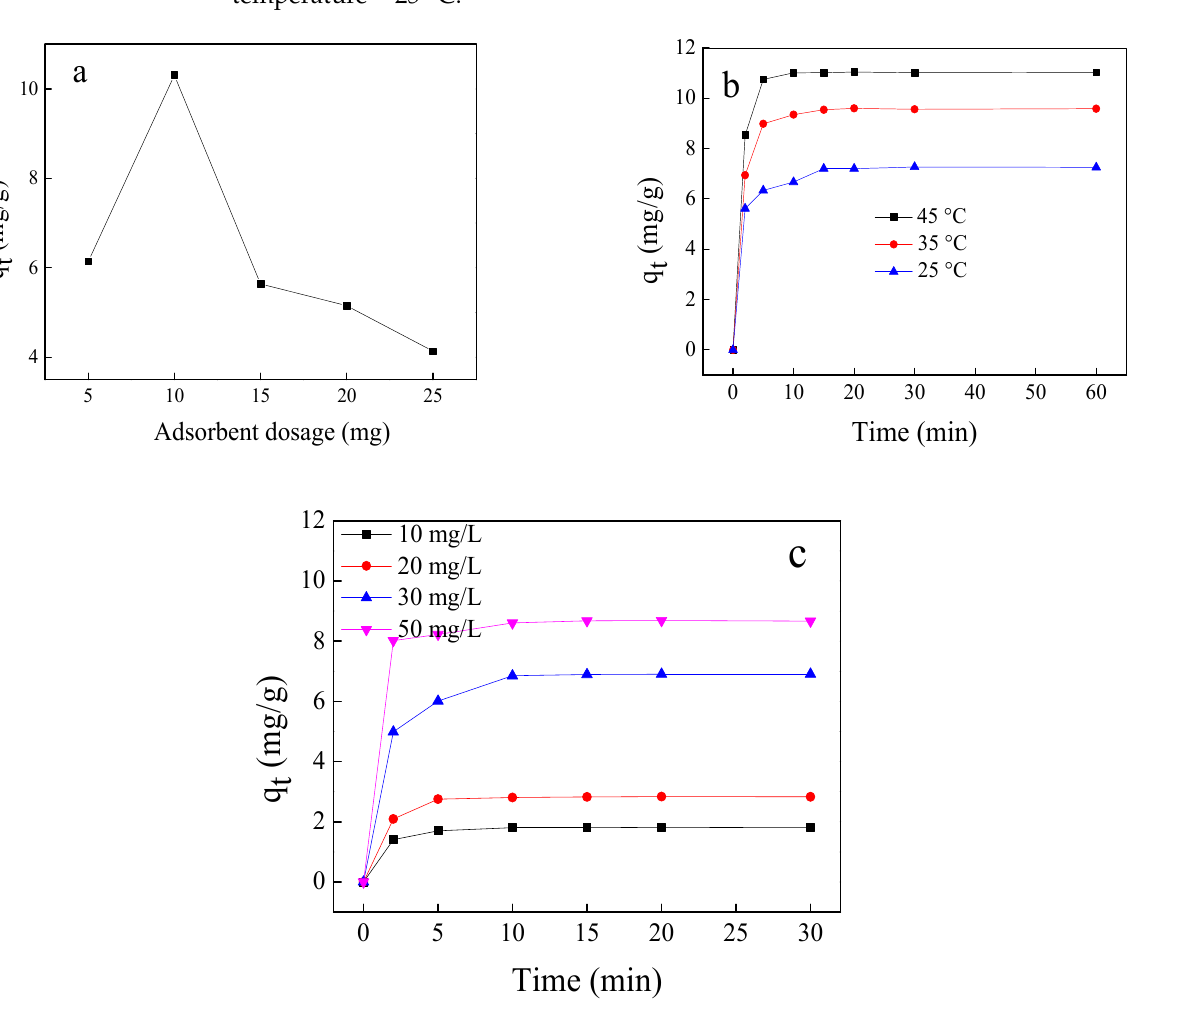
Figure 4. Effect adsorbent dose ( a ), temperature ( b ), different concentration, and contact time ( c ) on the adsorption capacity of Fe 3 O 4 @SiO 2 @N(CH 3 ) 3+